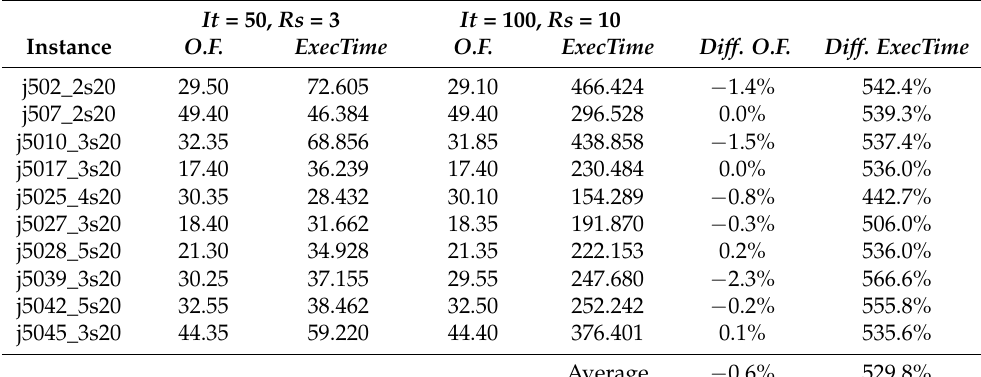
Table 6. Results of the pre-experiment for instances with 50